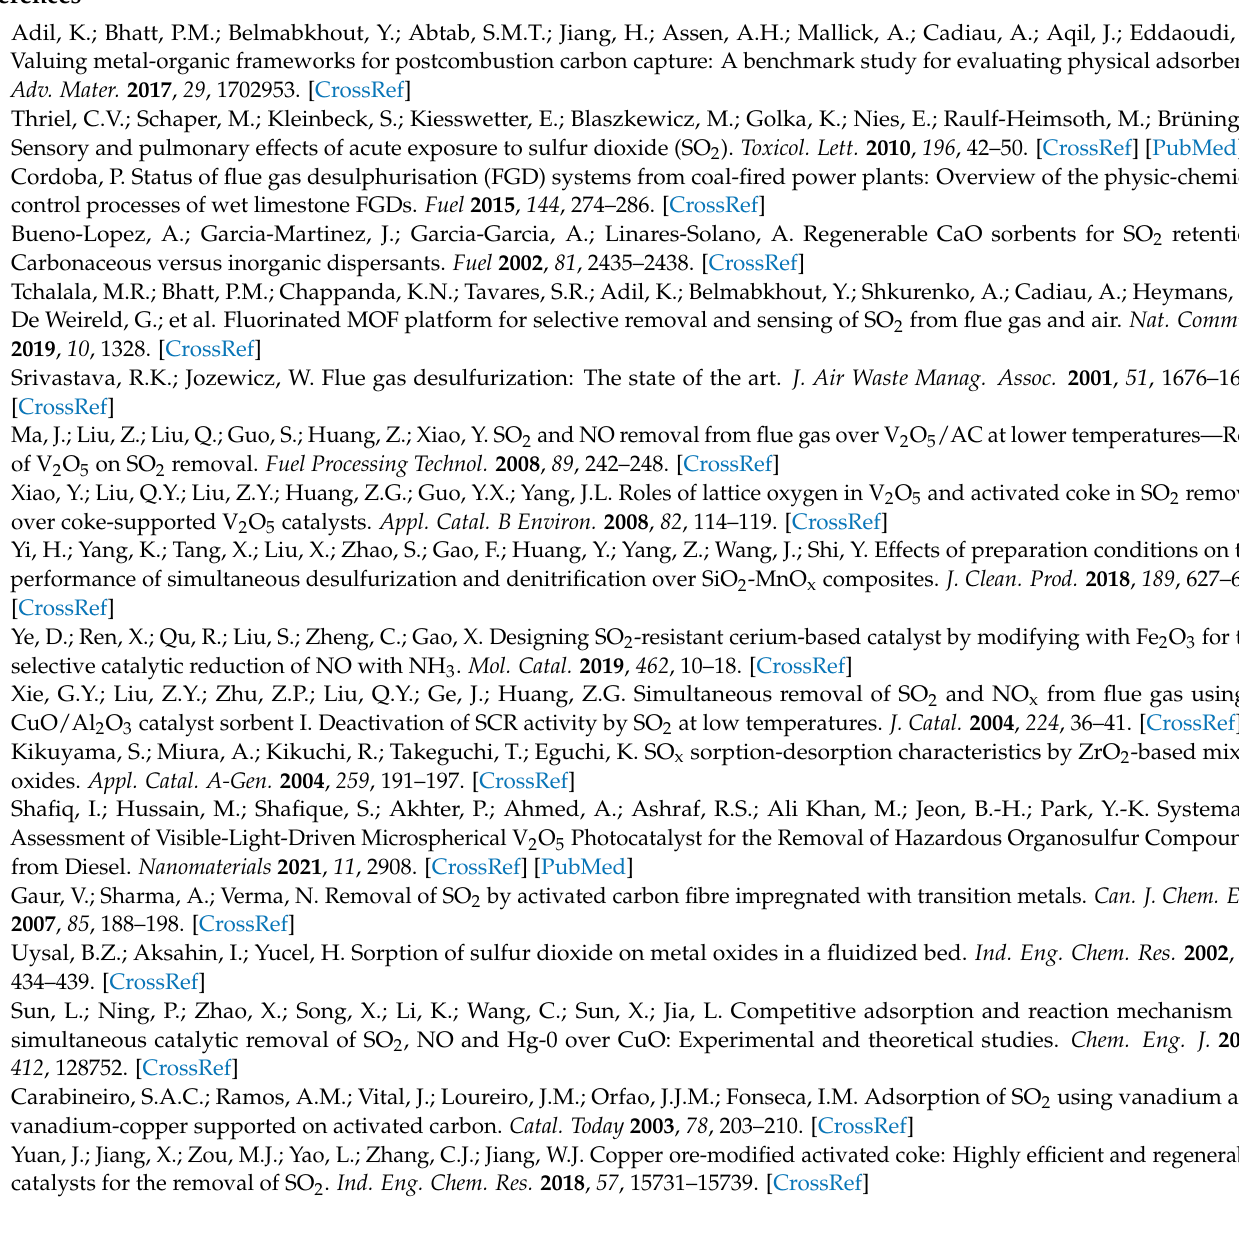
Figure S2: SEM image of CuO − NC; Figure S3: A schematic flow chart of dynamic adsorption desulfurization system; Table S1: Porosity characteristics of nano −